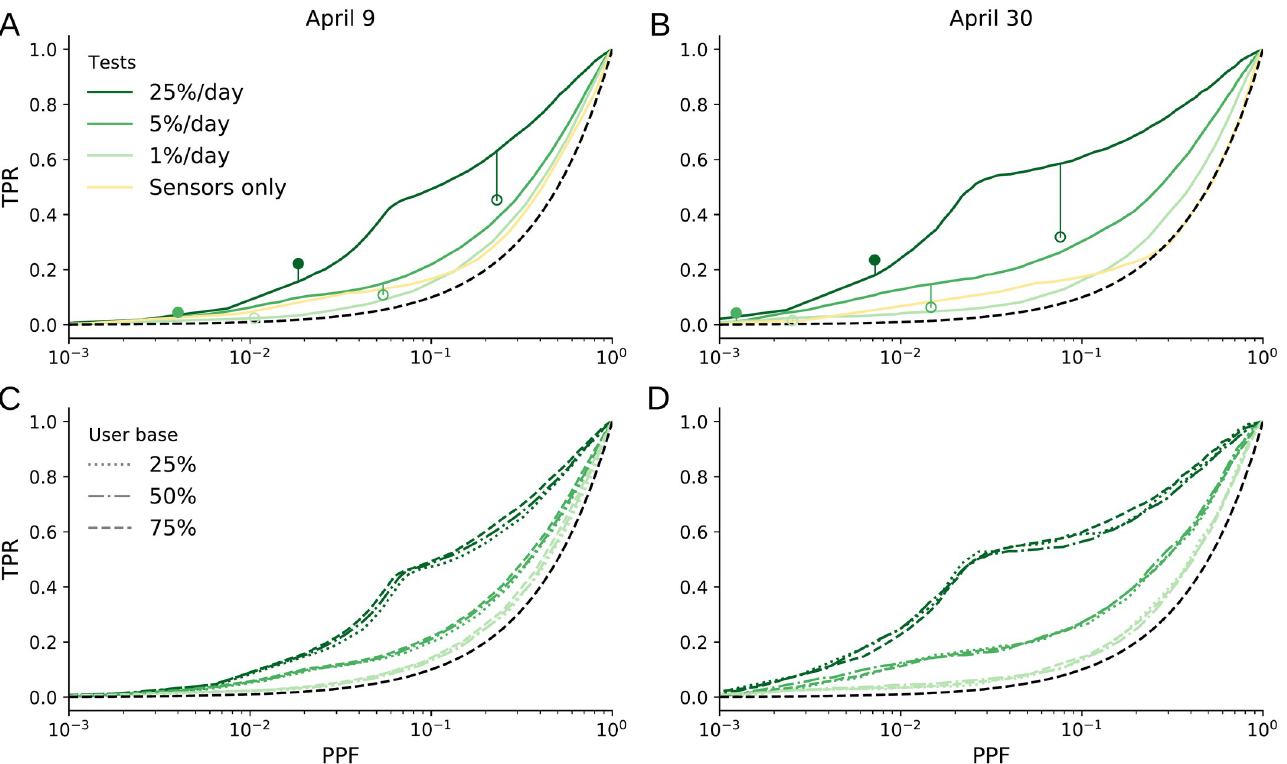
Fig 3. Receiver operating characteristic (ROC) curves for classification as possibly infectious. ROC curves trace out the true positive rate (TPR) vs. the predicted positive fraction (PPF) as the classification threshold is varied. TPR and PPF are given relative to the user base size ~ N . Green shades of the ROC curves from lighter to darker correspond to increasing diagnostic test rates f . Left column for April 9; right column for April 30. (a, b) For the ideal user base of ~ N = N ¼ 100% . For comparison, the filled circles are for a test-only scenario when only users with positive diagnostic tests are classified as positive. (The 1%/day case falls outside the plotting region; values for panel (a) are (7 × 10 − 4 , 0.008) and for (b) are (2 × 10 − 4 , 0.01).). The open circles are for a contact-tracing scenario in which additionally prior close contacts of users with positive diagnostic tests are classified as positive. Also shown is a sensors-only scenario in which 75% of the user base is assumed to provide daily body temperature readings. (c, d) For user bases consisting of neighborhoods in the network covering 25%, 50%, and 75% of the total population (S7 Fig), with the same test rates f in shades of green as in (a, b). The black dashed line represents a random classifier that provides a lower bound on